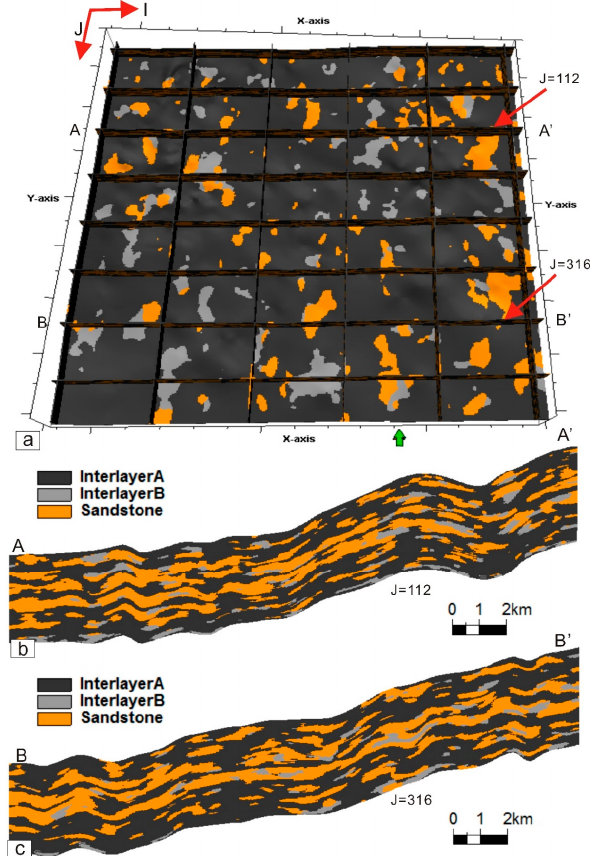
Figure 10. ( a ) 3-D cut slices of the entire S6 area at I (or X-axis) direction (5, 76, 147, 218, 289, 360) and J (or Y-axis) direction (10, 61, 112, 163, 214, 265, 316, 367); ( b , c ) Magnified cross-section of J = 112 and J = 316, respectively. Table 4. Computed variogram ranges for the entire zone. Table 4. Computed variogram ranges for the entire